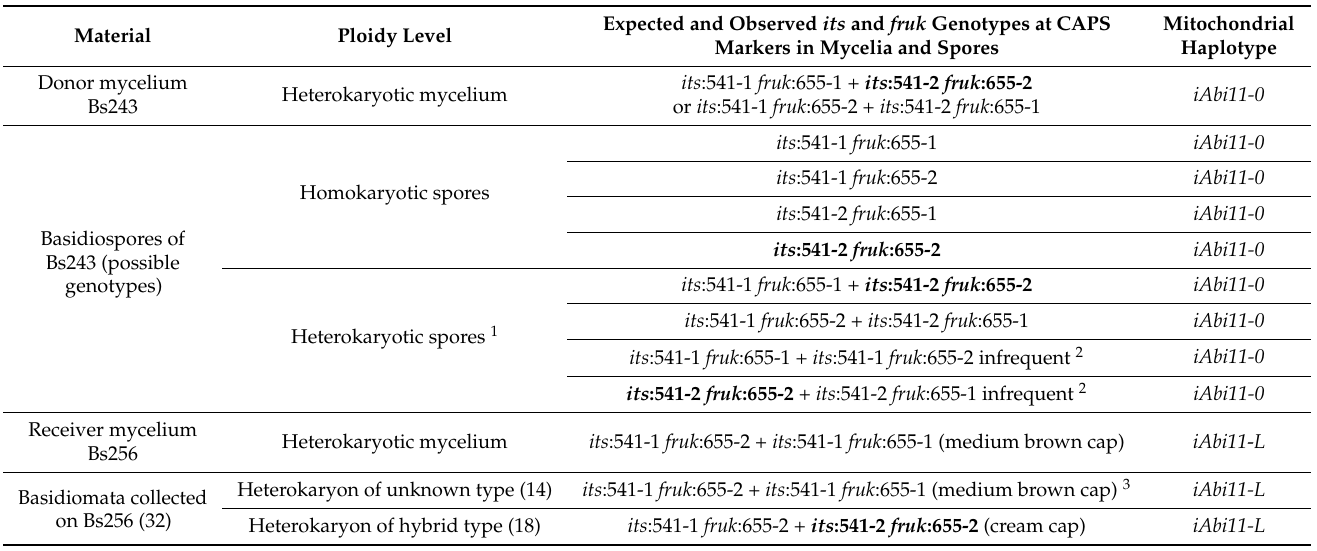
Table 3. Nuclear genotypes at CAPS markers and mitochondrial haplotypes in the experiment using Bs256 as receiver of airborne propagules from the culture trays of the donor